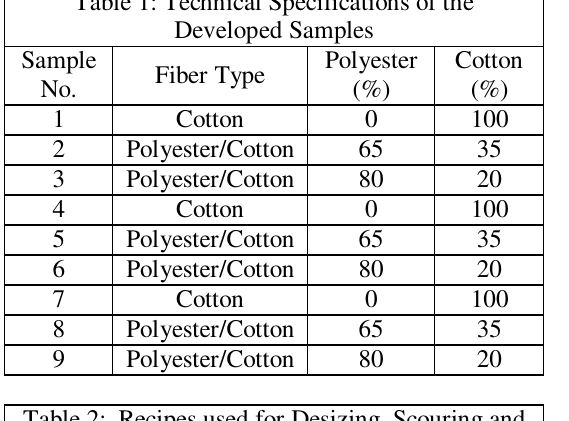
Table 2: Recipes used for Desizing, Scouring and Bleaching of Developed Samples